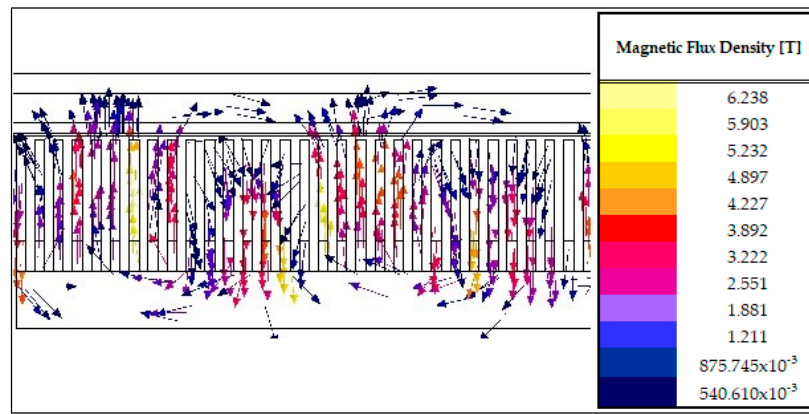
Figure 21. Transverse magnetic field density.